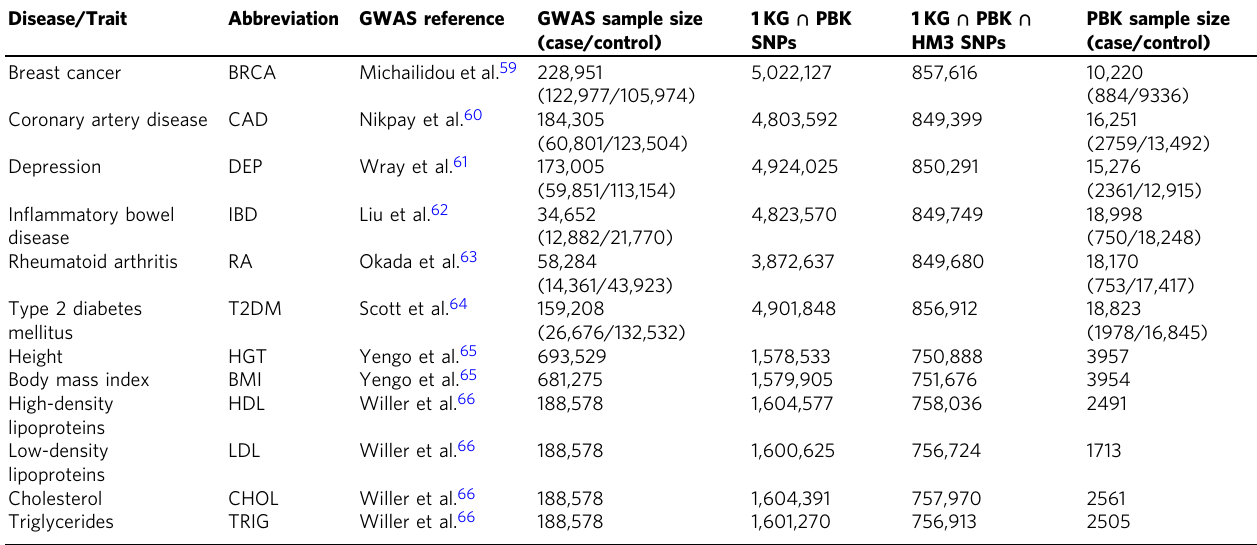
Table 1 Information on six common complex diseases and six quantitative traits